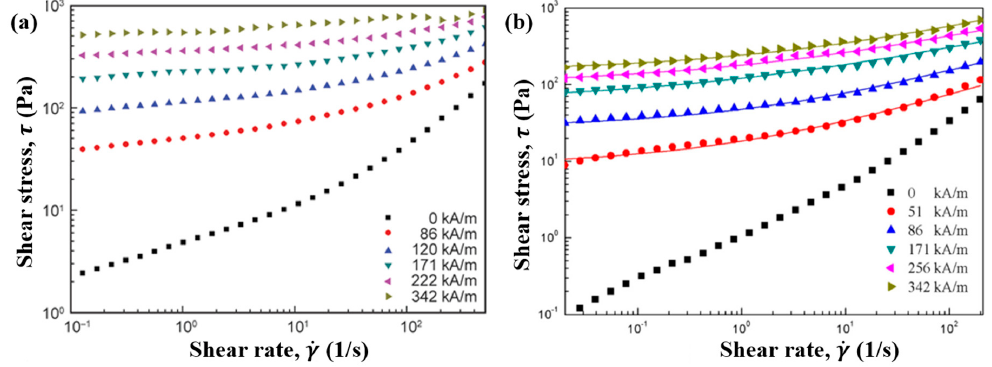
Figure 15. Shear stress curves of ( a ) Fe 3 O 4 /PANI based MR fluid (20 wt %) (Sim et al. [72], © BME-PT, 2015) and ( b ) Fe 3 O 4 / POA based MR fluid (10 vol %) (Lee et al. [81], © by authors, 2019). 2015) and ( b ) Fe 3 O 4 /POA based MR fluid (10 vol %) (Lee et al. [81], © by authors, 2019).